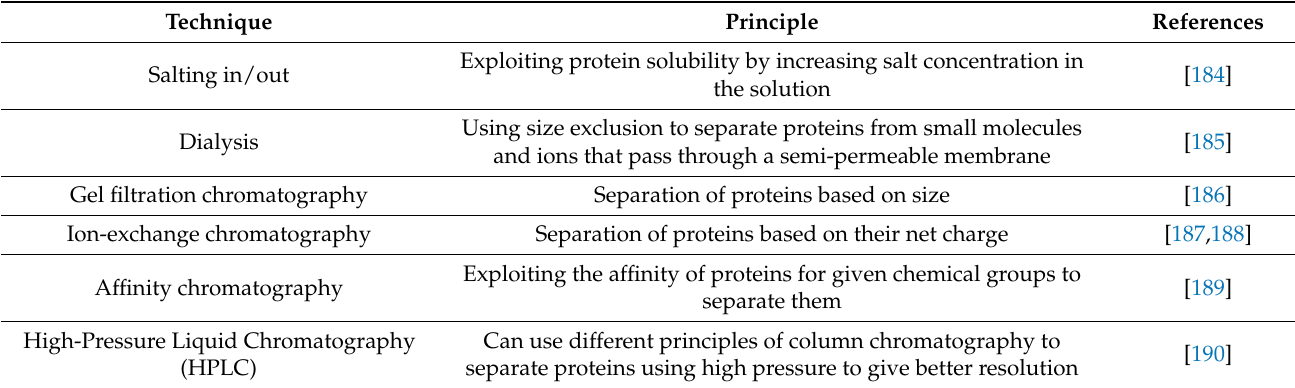
Table 3. Protein purification